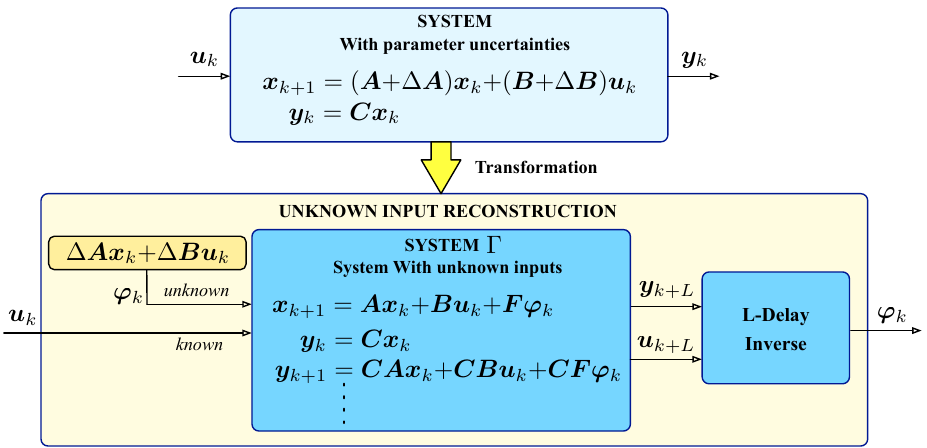
Figure 1. Unknown input reconstruction